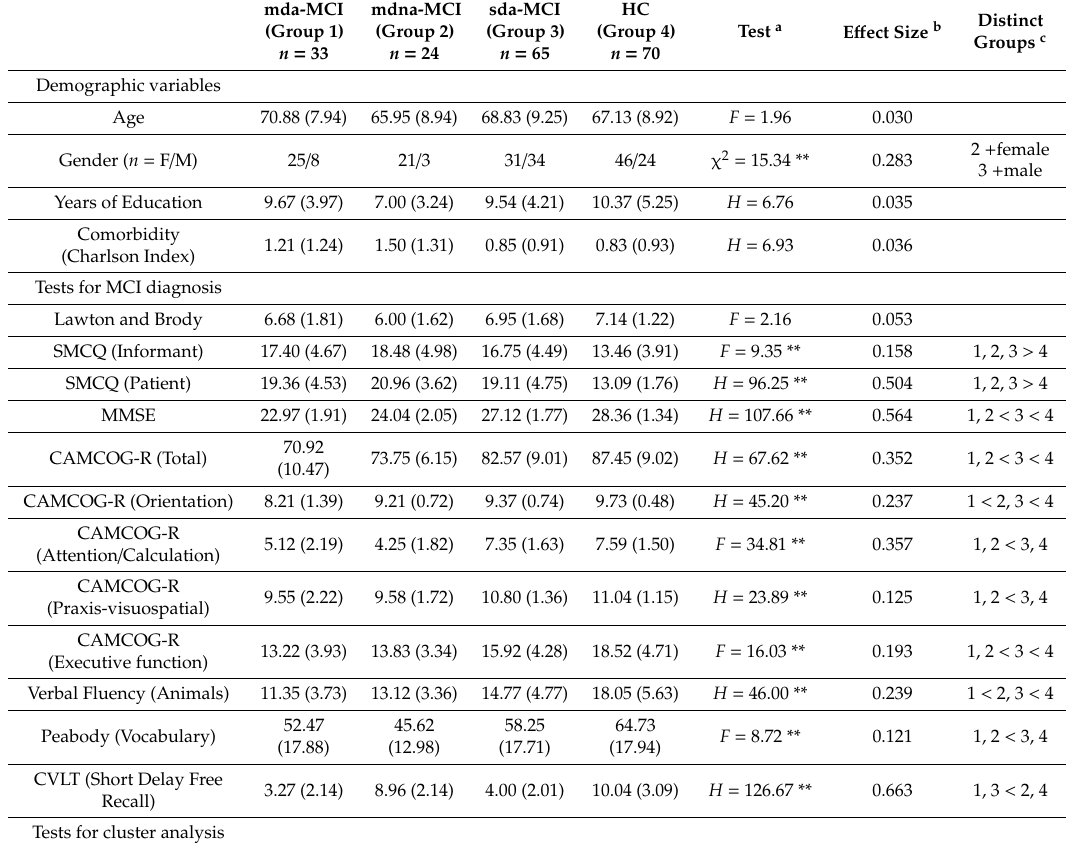
Table 1. Demographic and neuropsychological characteristics (raw measures, means and standard deviations in parentheses) of the participants ( n = 205) diagnosed using clinical standard MCI criteria: Group 1 = multiple-domain amnestic MCI (mda-MCI), Group 2 = multiple-domain non amnestic MCI (mdm-MCI), Group 3 = single-domain amnestic MCI (sda-MCI), and Group 4 = healthy controls (HC). Statistical measures (ANOVA F, Kruskal–Wallis non-parametric H and standard χ 2 ), e ff ect size ( ŋ 2